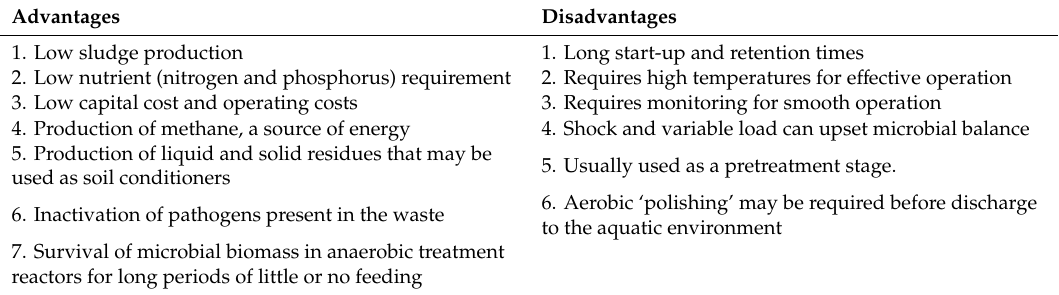
Table 2. Advantages and disadvantages of anaerobic waste treatment